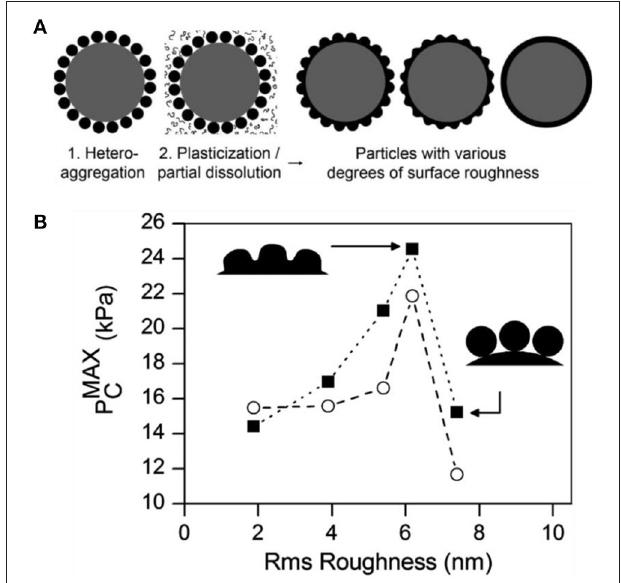
FIGURE 11 | Schematic illustration of fabrication of particles with different surface roughness (A) and maximum capillary pressure for decane-in-water emulsions stabilized by particles with different surface roughness (B) (San-Miguel and Behrens, 2012). Reprinted with permission from San-Miguel and Behrens (2012) . Copyright 2012 American Chemical